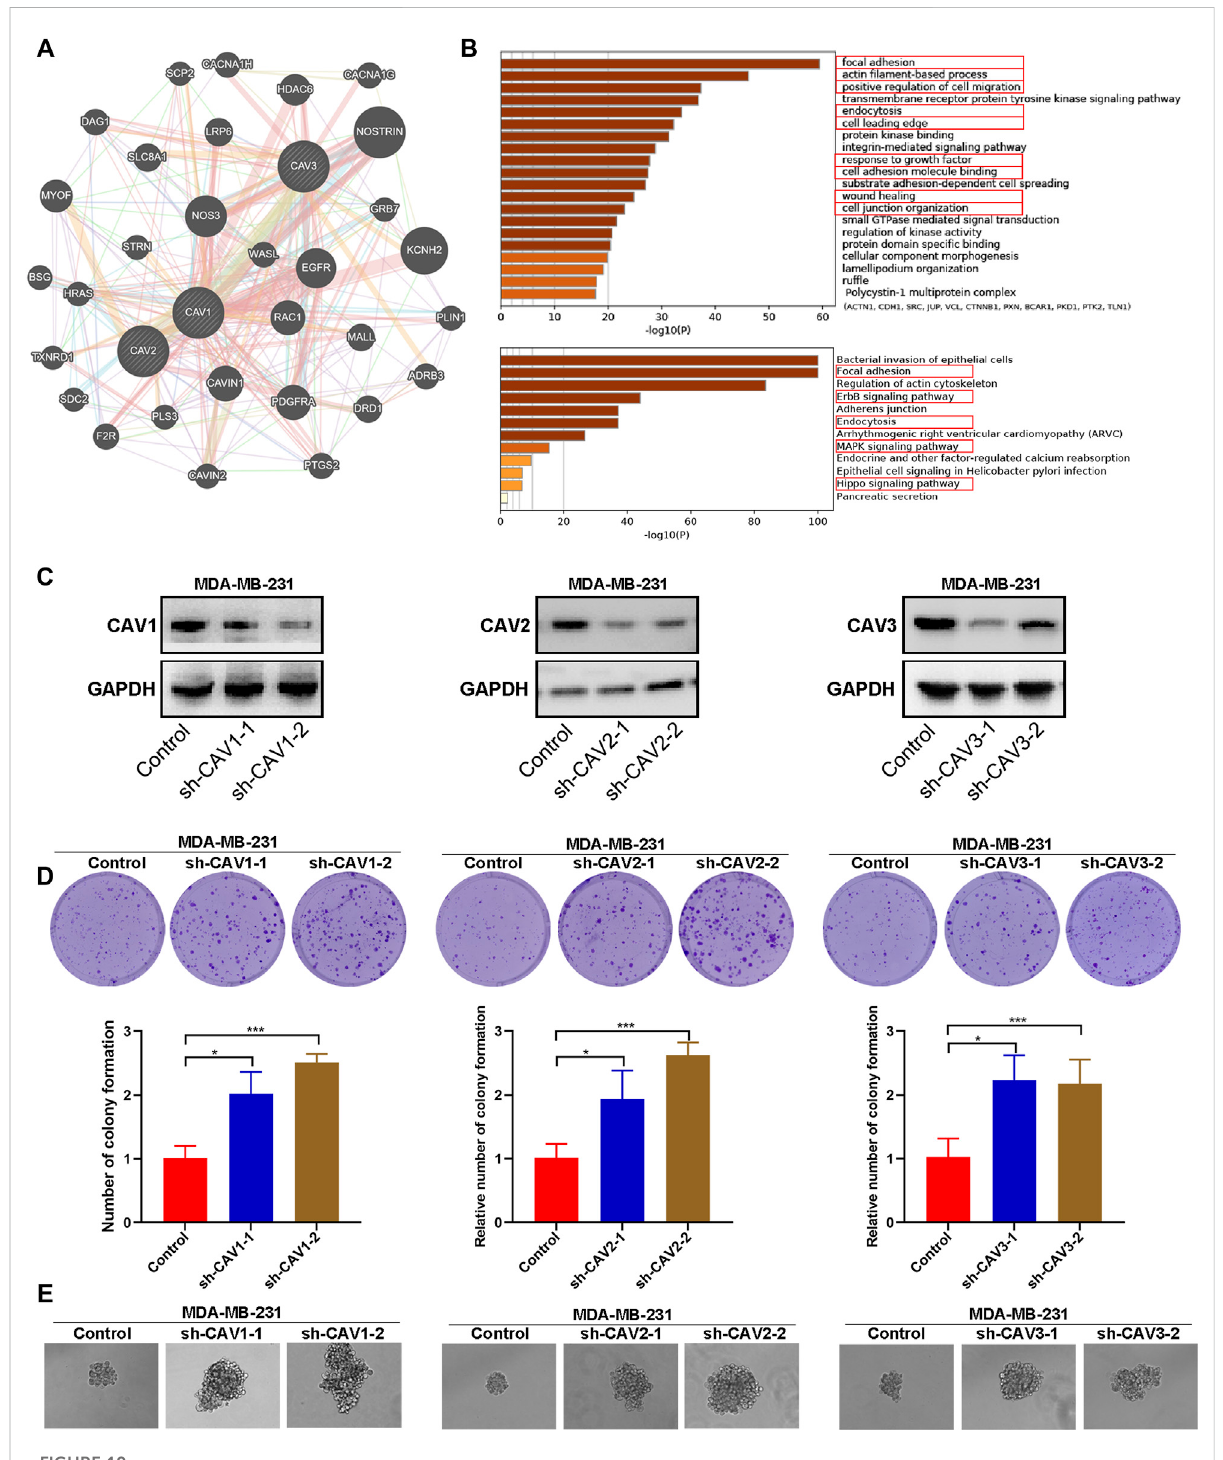
FIGURE 10 Functional enrichment, colony, and sphere formation analysis of CAVs in BC. (A,B) GO and KEGG pathways and functions analysis of CAVs and the enriched gene in BC. (C) The ef fi ciency of CAV silencing was con fi rmed by WB. (D) Colony formation ability was determined by using a colony formation assay. (E) Quanti fi cation of the sphere formation ability of CAV-transfected MDA-MB-231 cells. * p < 0.05, ** p < 0.01, *** p < 0.001.